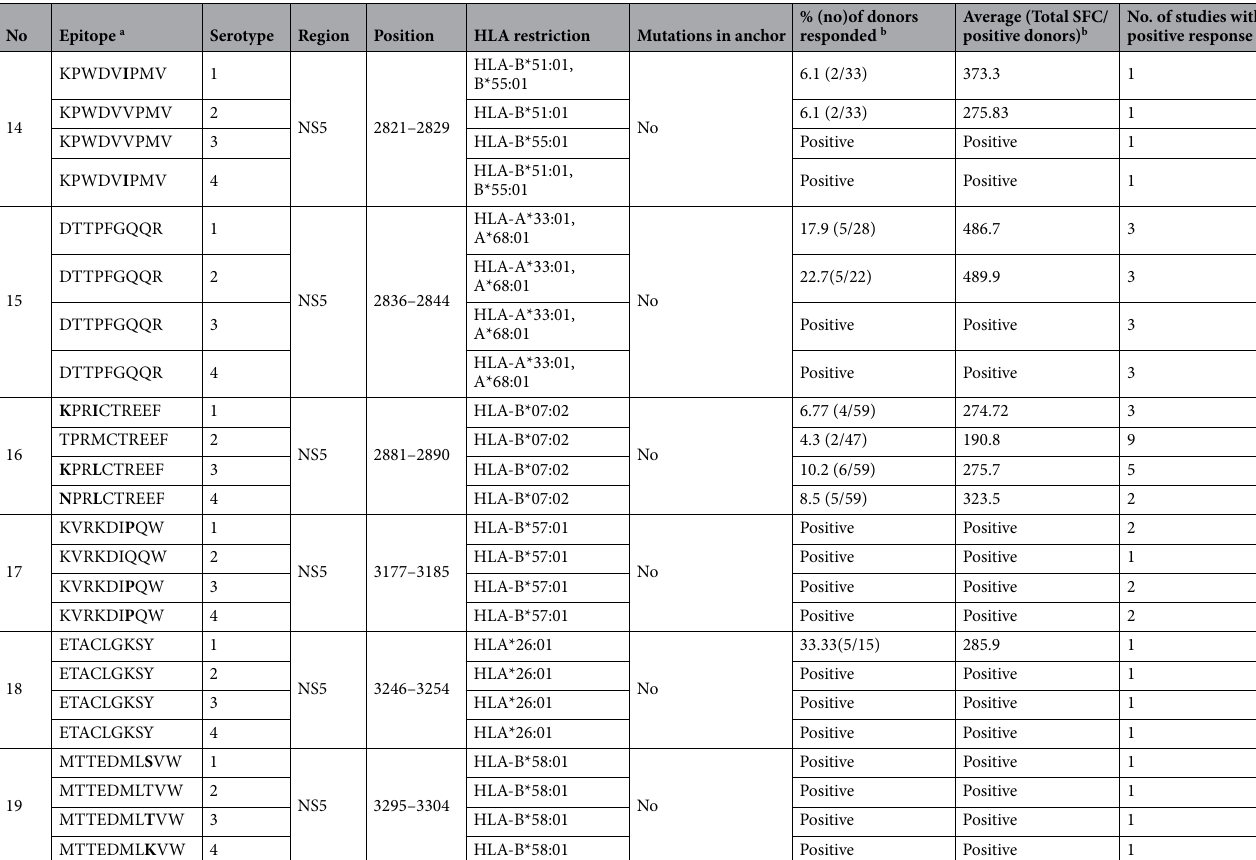
Table 2. Characteristics of the conserved epitopes. a Mutations from the DENV2 variant are in bold. b Data from the Sri Lanka 15 or the Nicaragua 39 cohort studies.